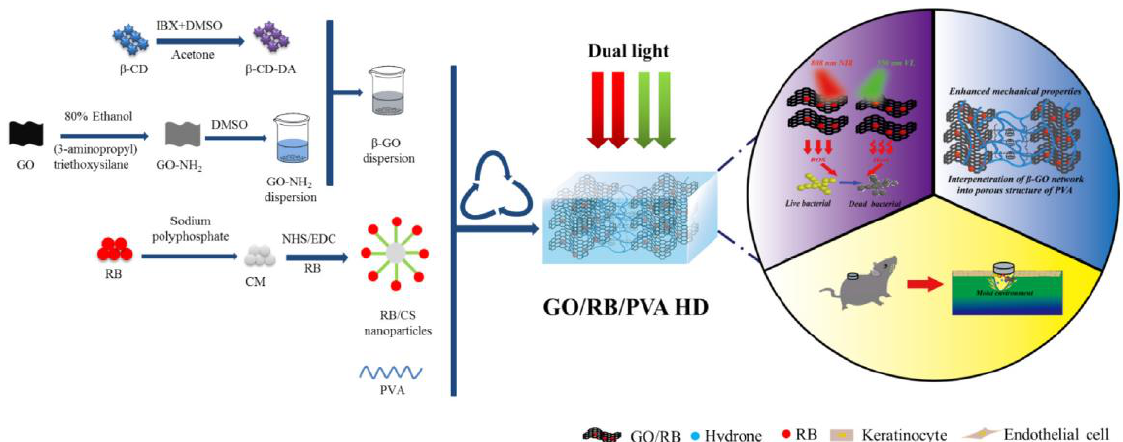
Figure 20. Schematic illustration of the synthesis of the β-graphene oxide (GO)/ rose bengal (RB)/poly(vinyl alcohol) (PVA) hydrogel and the promotion mechanisms of mechanical property, antibacterial activity and wound healing. Reprinted with permission. Copyright 2021, Elsevier [42].